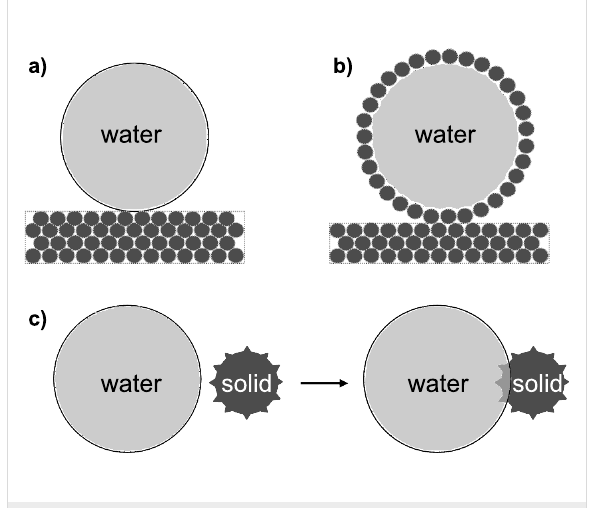
Figure 4: Formation of a liquid marbles: a) droplet contacting substrate composed of loose grains, b) attachment of grains to encapsulate a droplet, c) minimisation of surface free energy by replacement of a portion of the liquid–vapor interface by a portion of the rough solid surface from an attaching